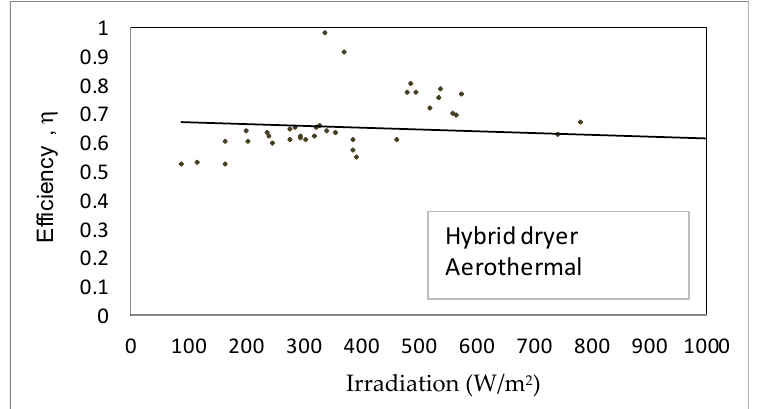
Figure 9. Efficiency of the hybrid dryer. Figure 9. E ffi ciency of the hybrid dryer.